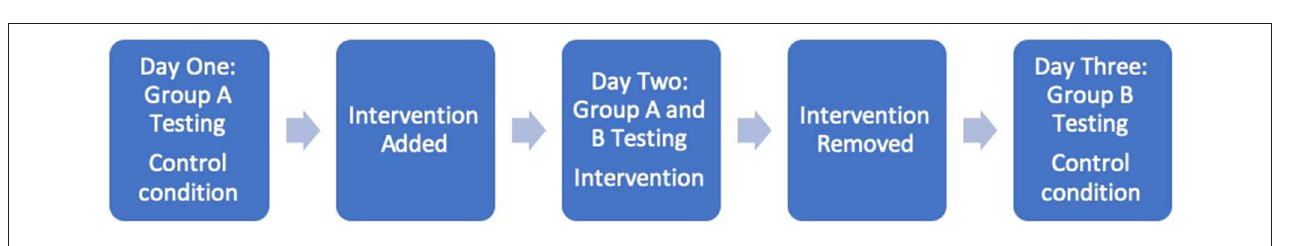
FIGURE 2 | Experimental design and exposure